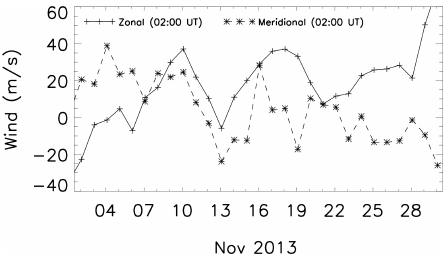
Figure 12. Zonal (solid line) and meridional (dashed line) wind components at 93km height over Cachoeira Paulista, measured at 02:00UT during November 2013.